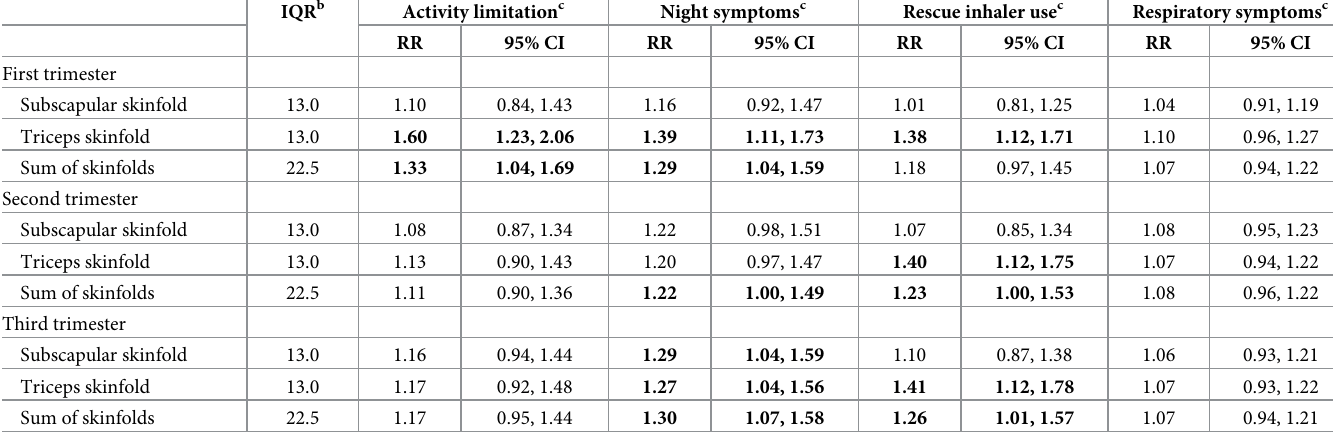
Table 2. Adjusted a association for an IQR-increase in maternal body composition associated with incidence of asthma symptoms in the Breathe-Wellbeing, Envi- ronment, Lifestyle, and Lung Function Study, 2015–2019,